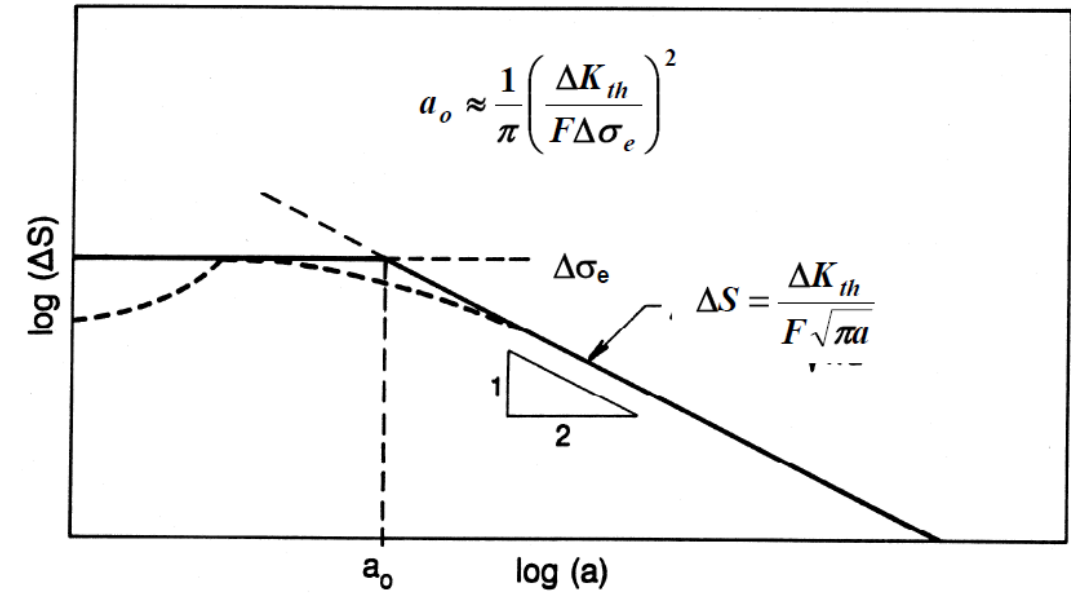
Figure 1. Kitagawa diagram relating fatigue endurance limit and crack threshold [17].